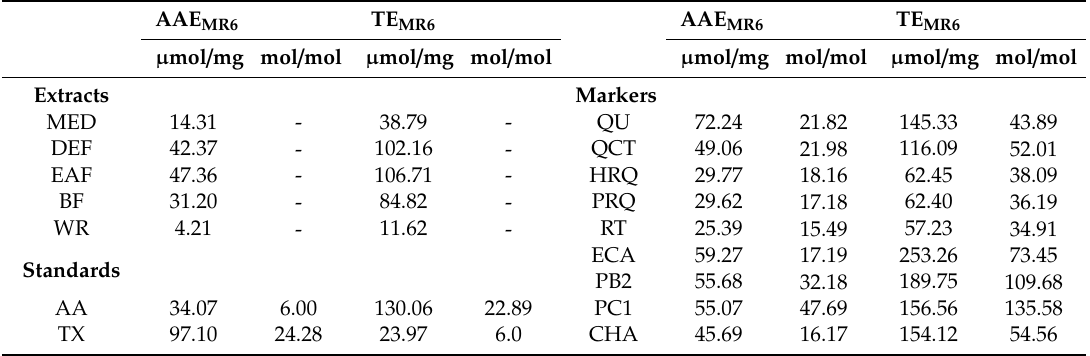
Table 1. Scavenging capacity towards multiple reactive oxygen / nitrogen species (ROS / RNS) in equivalents of standard